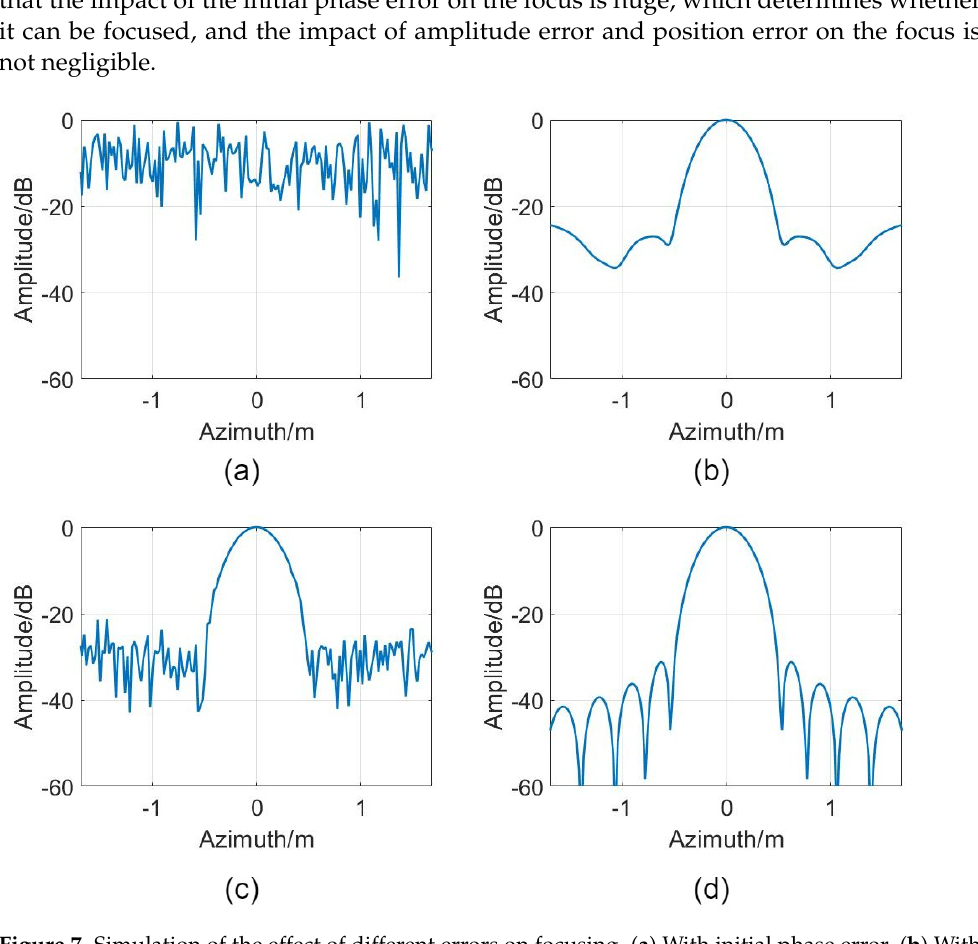
Figure 7. Simulation of the effect of different errors on focusing. ( a ) With initial phase error. ( b ) With amplitude error. ( c ) With position error. ( d ) After